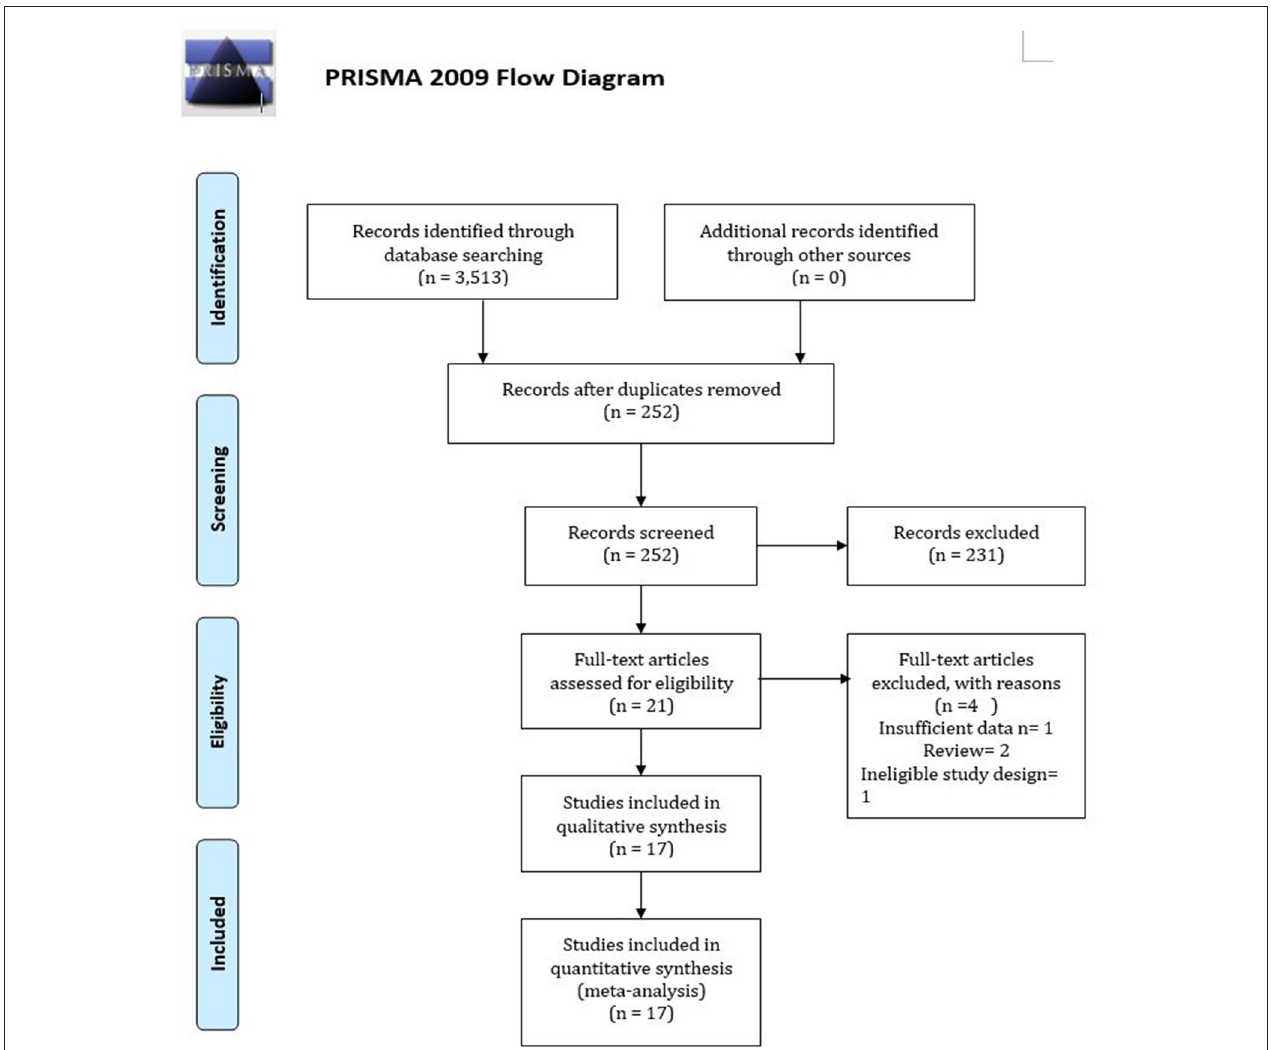
FIGURE 1 | Flow diagram of the study selection